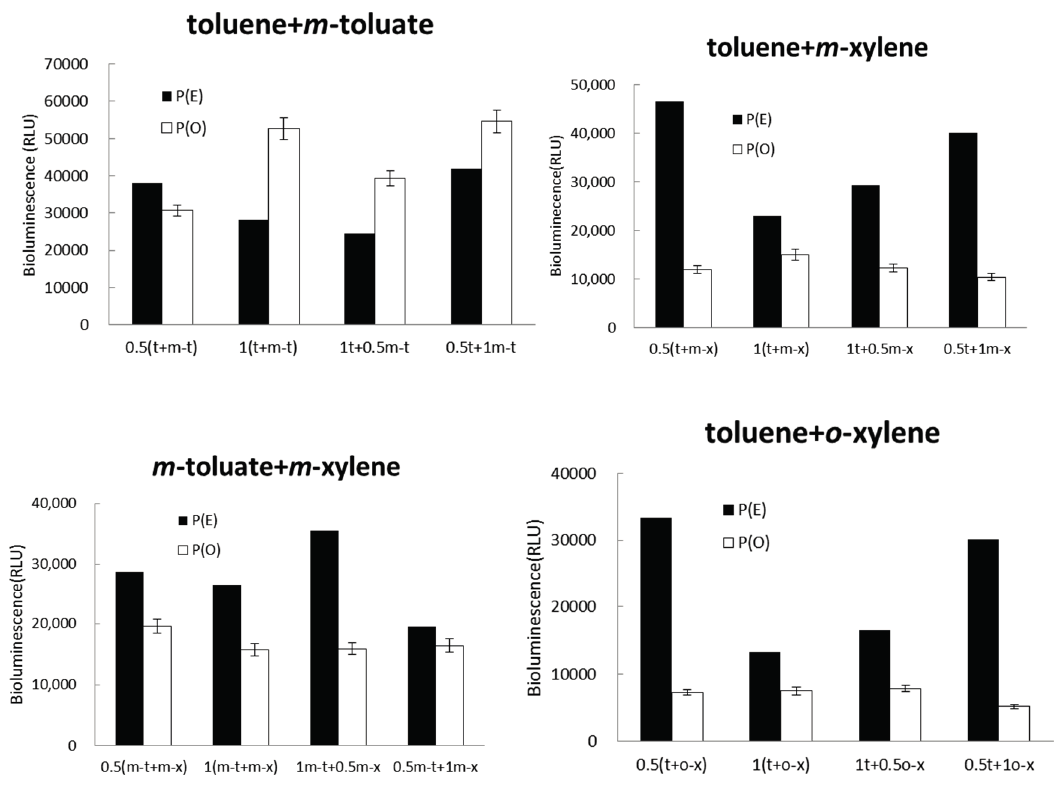
Figure A1. Comparison between P(O) and P(E) bioluminescence intensities in the presence of binary inducer mixtures. X -axis “1t + 0.5m-x” represents binary mixtures of toluene and m -xylene, and final concentration of each is 1 and 0.5 mM,